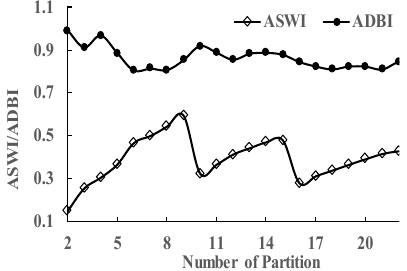
Figure 2. Historical distribution of DHI. ( a ) DHI calculated by SPI, ( b ) DHI calculated by SPEI, ( c ) DHI calculated by SP*ETI.